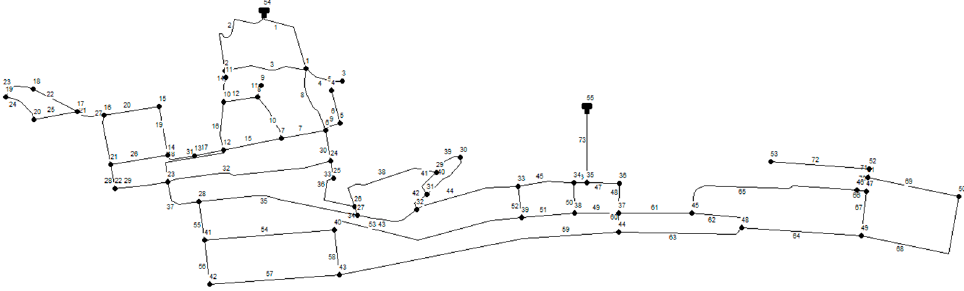
Figure 1. Network of Praia a Mare (Cosenza, Italy).